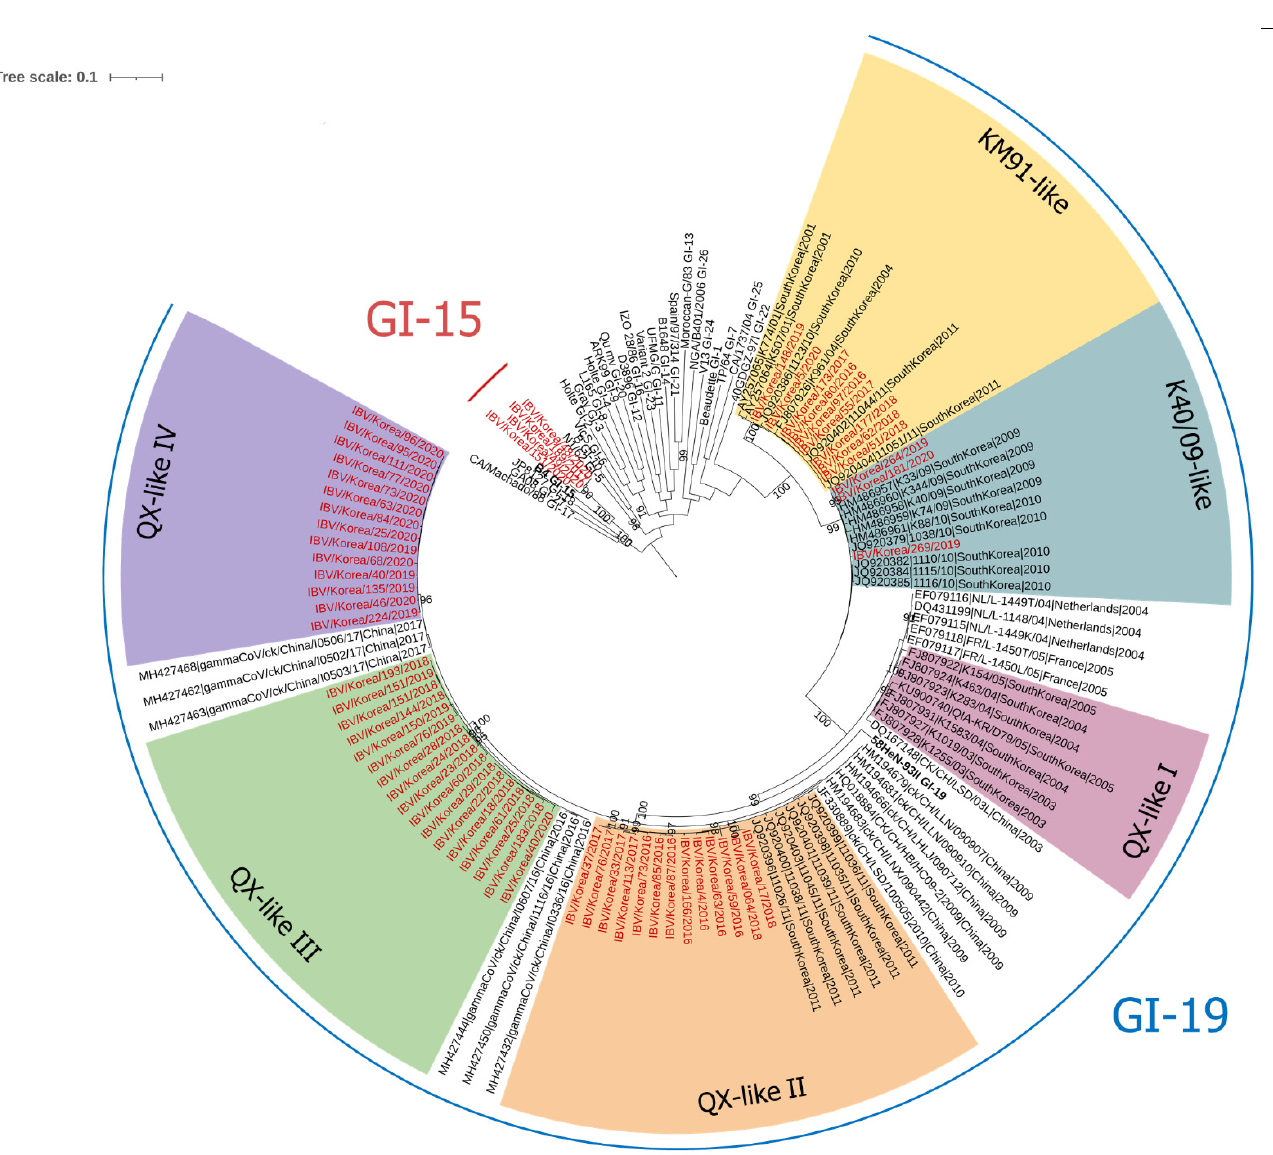
Figure 1. Maximum-likelihood phylogenetic tree of the IBV spike 1 subunit ( S1 ) gene. Each prototype of the lineages (GI-15; B4 and GI-19; 58HeN-93II) are in bold font. Taxa colored red are the IBVs isolated in this study. The six subgroups of the South Korean GI-19 IBV strain are annotated with different background colors.